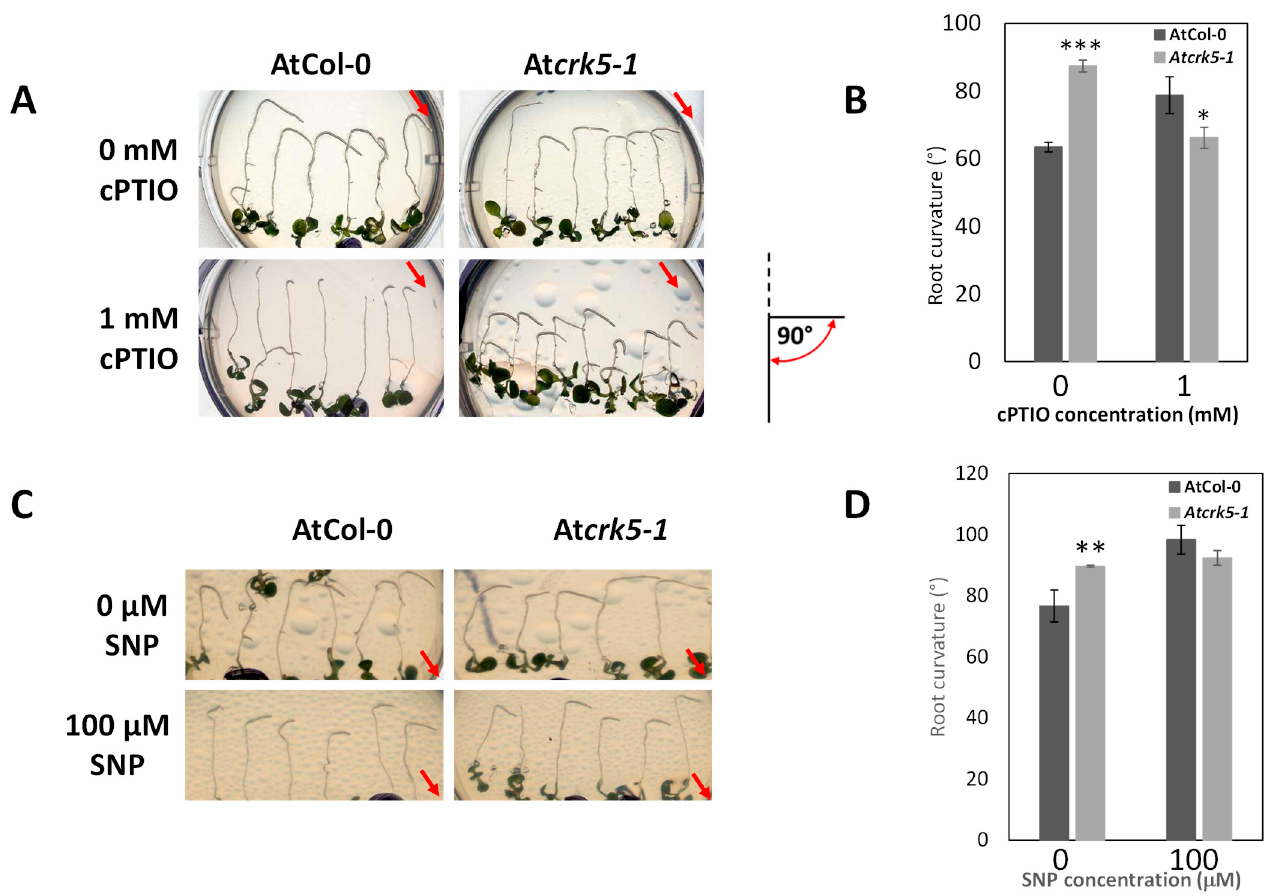
Figure 8. Effect of the manipulation of the endogenous NO level on root gravitropic response. Seedlings were grown vertically for 5 days, then they were transferred to media containing the NO scavenger cPTIO (2-4-carboxyphenyl-4,4,5,5- tetramethylimidazoline-1-oxyl-3-oxide, A , B ) or the NO donor SNP (sodium nitroprusside, C , D ) and immediately rotated by − 135° for 24 h. Representative pictures ( A , C ) and quantitative analysis of the effect on the gravitropic bending of the wild type (AtCol-0) and mutant (At crk5-1 ) roots ( B , D ) are shown. Red arrows indicate the direction of the gravity vector. The pictogram at the Figure 8 A shows the mode of the determination of the root curvature degree, the red semicircle with arrows indicates the measured angle. Asterisks indicate significant differences at * p < 0.1, ** p < 0.01 and *** p < 0.001 between wild type (AtCol-0) and mutant (At crk5-1 ). Measurements were performed with at least 30 seedlings per each line. Bars indicate standard error. At least two biologically independent experiments were carried out with the similar statistical results.